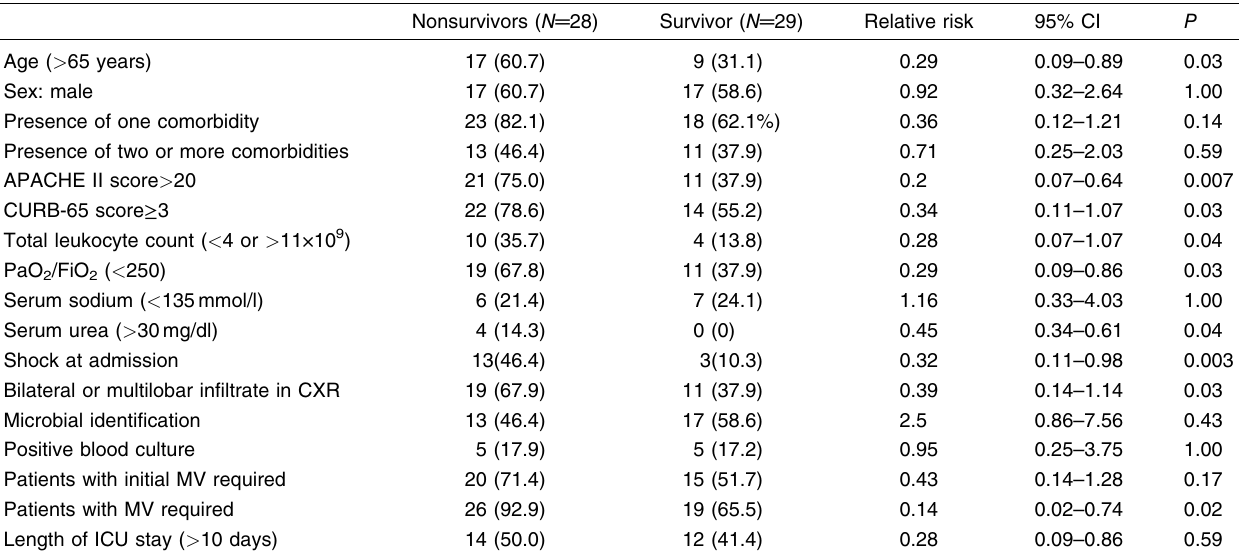
Table 4 Univariate analysis for in-ICU mortality among patients with severe